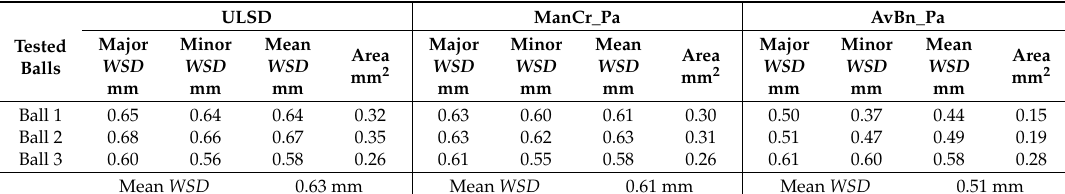
Table 4. Summary of wear characteristics of the tested fuels.